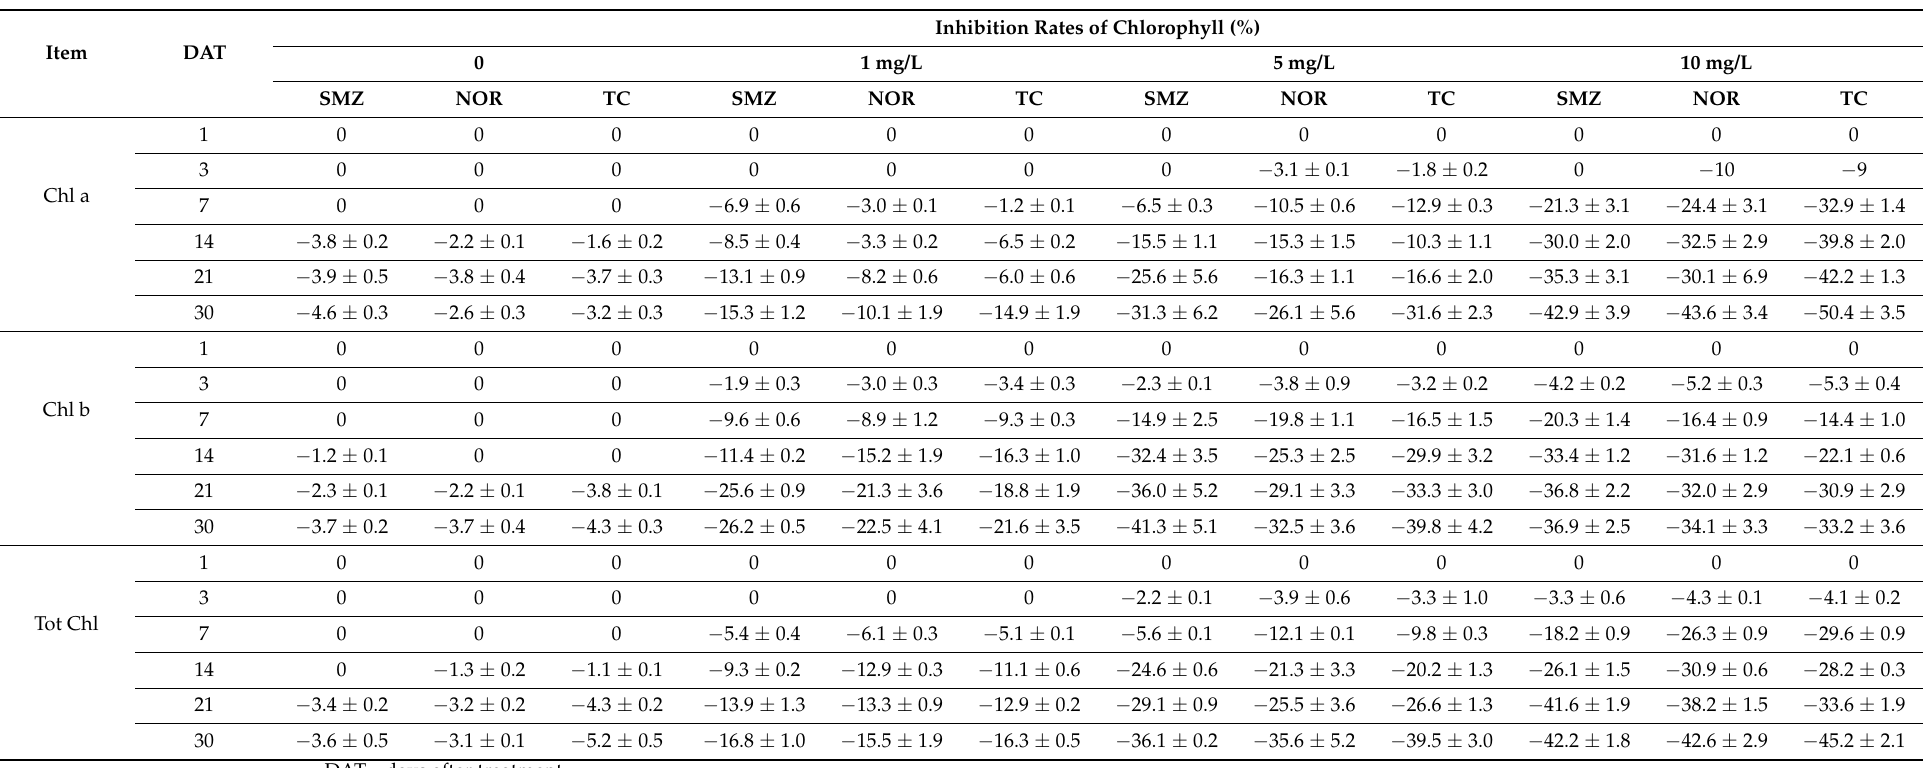
Table 3. Effects of antibiotics on concentrations of Chl a, Chl b, and total Chl in leaf tissues of water lettuce ( Pistia straiotes ). Values are the mean ± S.D. of three parallel individuals in each container, with three measurements from each